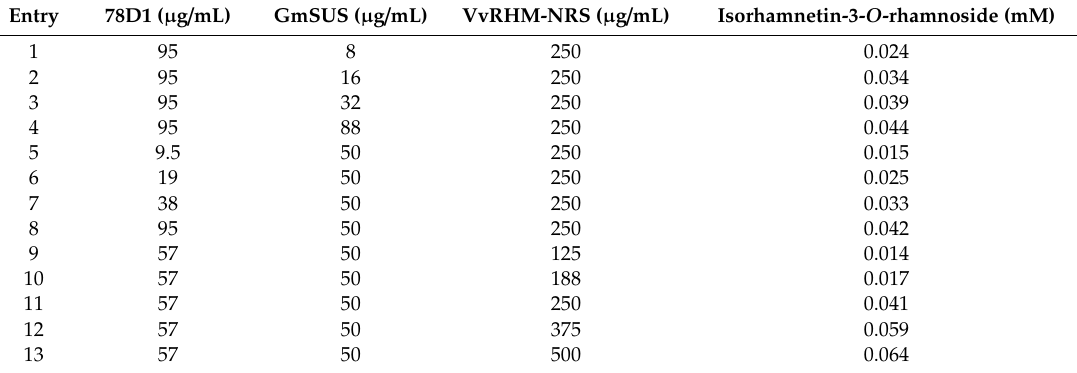
Table 1. Effect of Enzyme Concentration on Product Yields of Isorhamnetin-3- O -rhamnoside a.